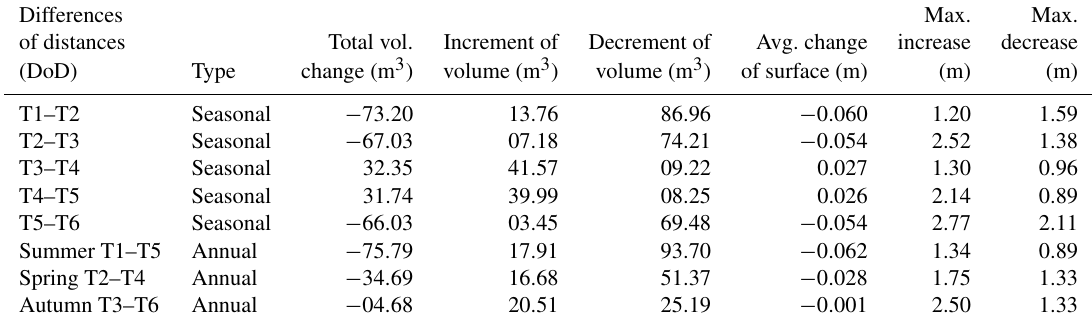
Table 2. Summary statistics of volumetric and vertical changes of the selected cave floor extent during the monitored period. Differences Max. Max. of distances Total vol. Increment of Decrement of Avg. change increase decrease (DoD) Type change (m 3 ) volume (m 3 ) volume (m 3 ) of surface (m) (m) (m) − 73 .